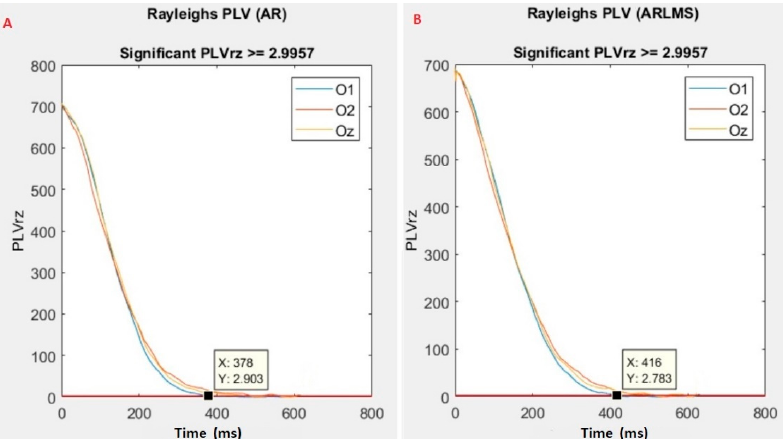
Figure 6. Rayleigh's Z value (PLVrz) for twice the prediction length (256 ms). ( A ) shows the AR model; ( B ) shows the LMS-based AR model. The red line indicates the significance level with a value of 2.9957. The box shows the time point (X-axis) at which the significant line is crossed with its respective PLVrz value